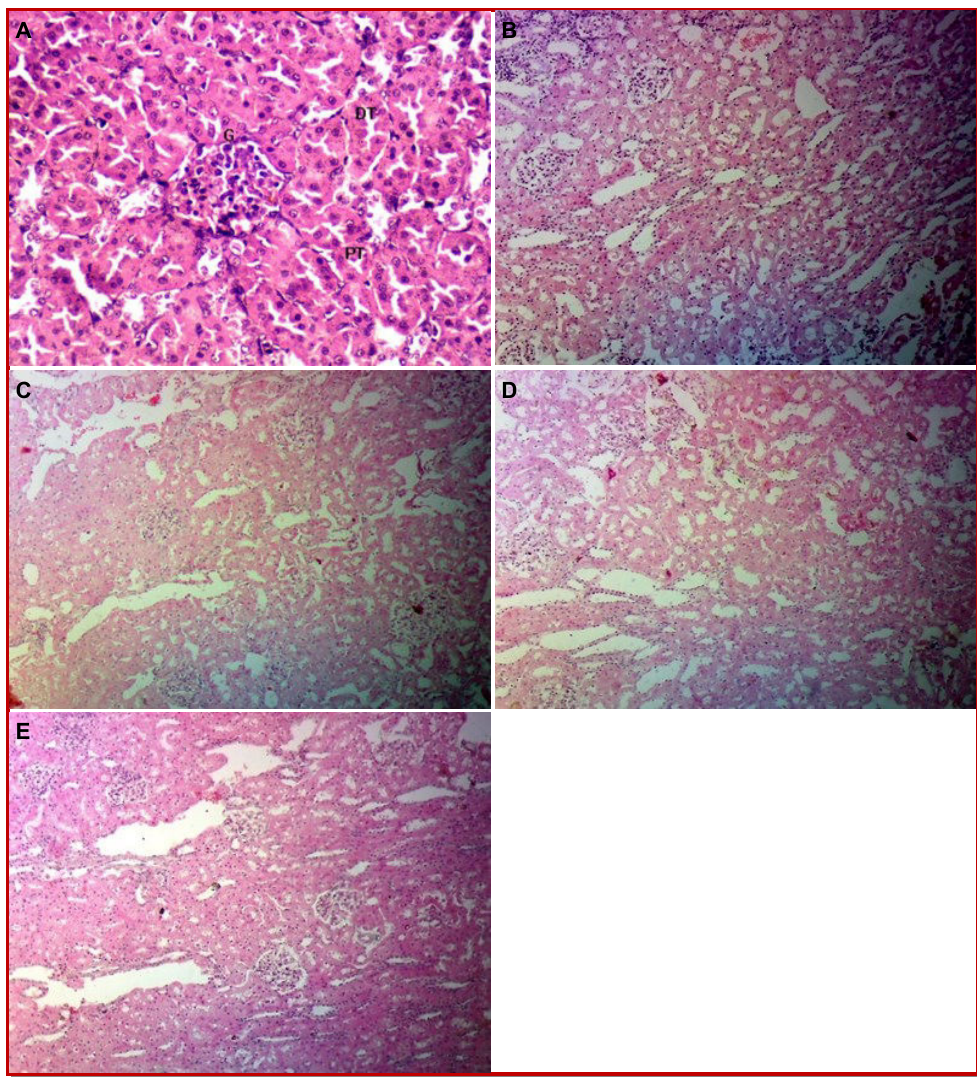
Figure 1: Histopathological analysis of rabbit's kidney. A) control group; B) Disease control; C) Standard; D) Methanol extract, 500 mg/kg (nephroprotective study); E) Methanol extract, 500 mg/kg (nephrocurative